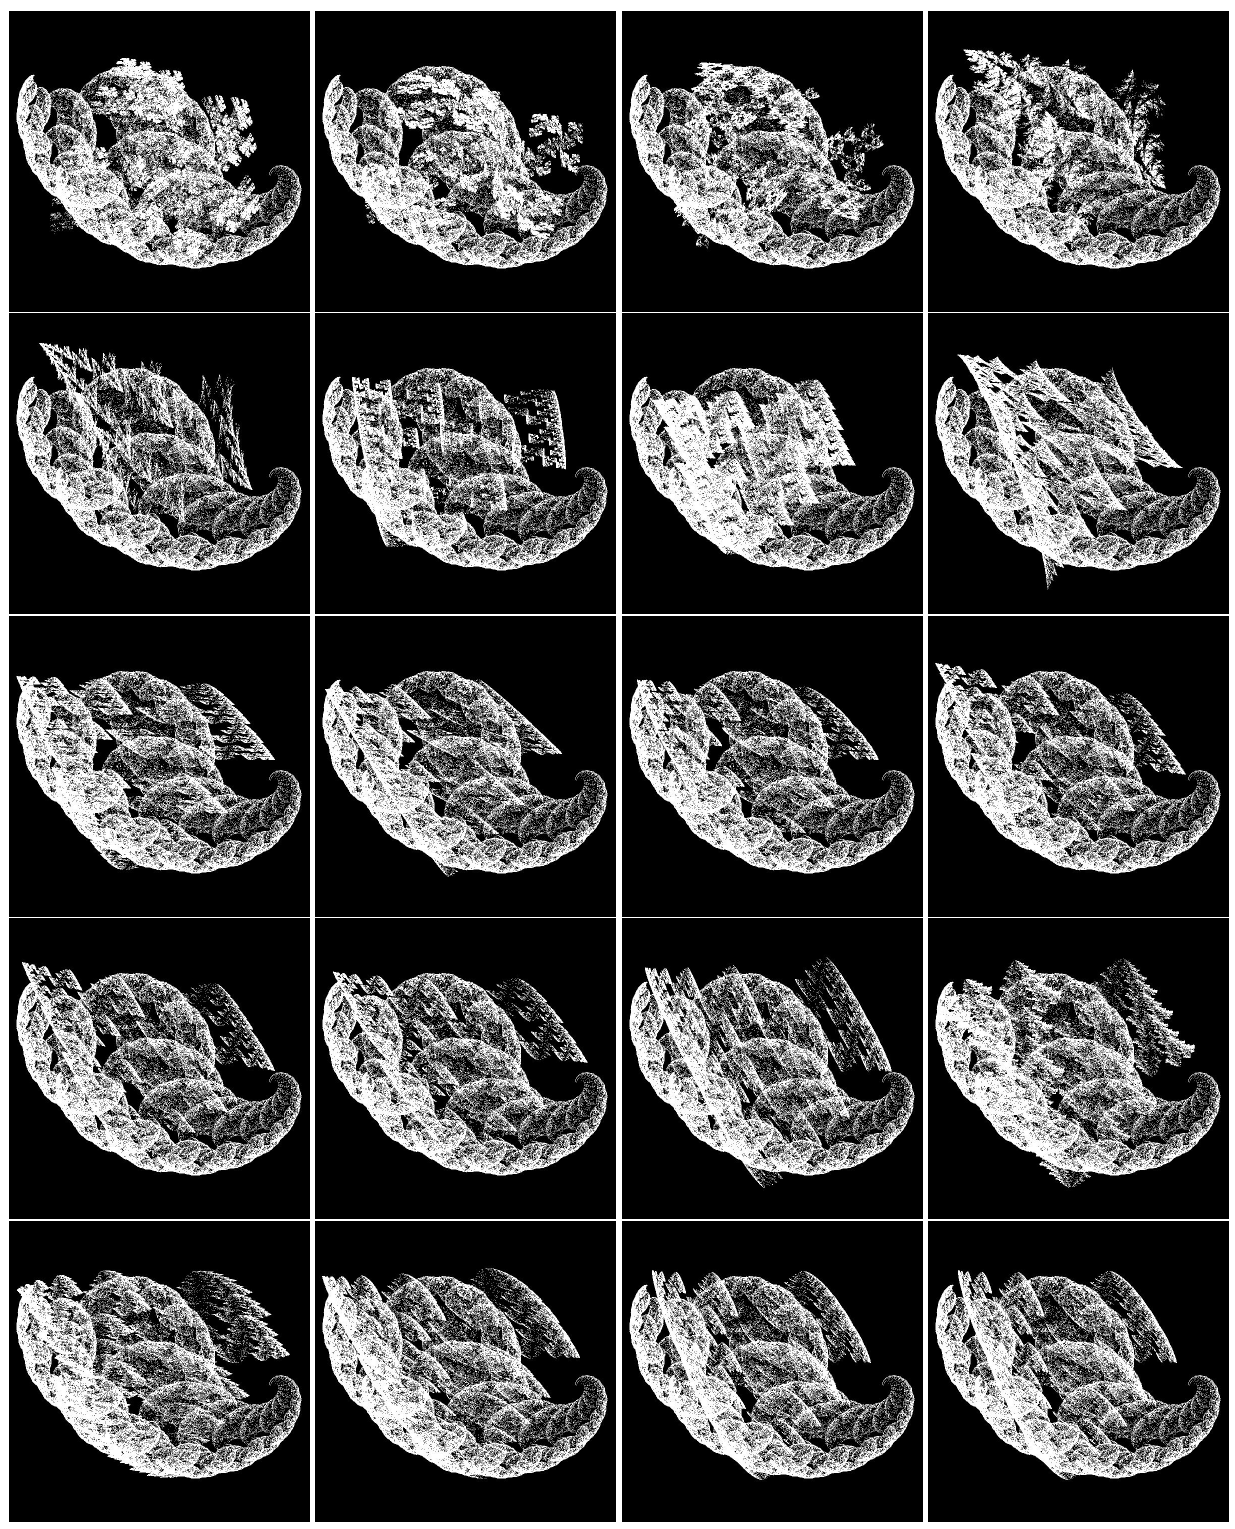
Figure 10. ( left – right , top – bottom ): Evolution of the union between the original and the recon- structed images for 0–380 iterations (step size, 20